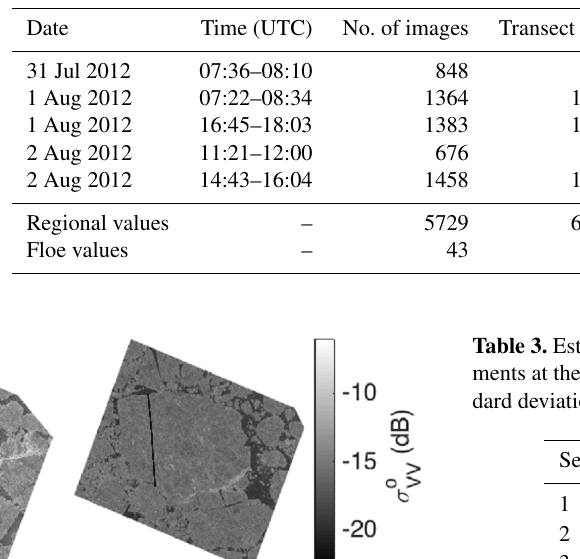
Table 2. Overview of the images captured during the helicopter flights. Only images without open water fraction are included in the study. The bottom entries show the regional values derived from all five flights, and the local values of the floe investigated in T3 and T4.